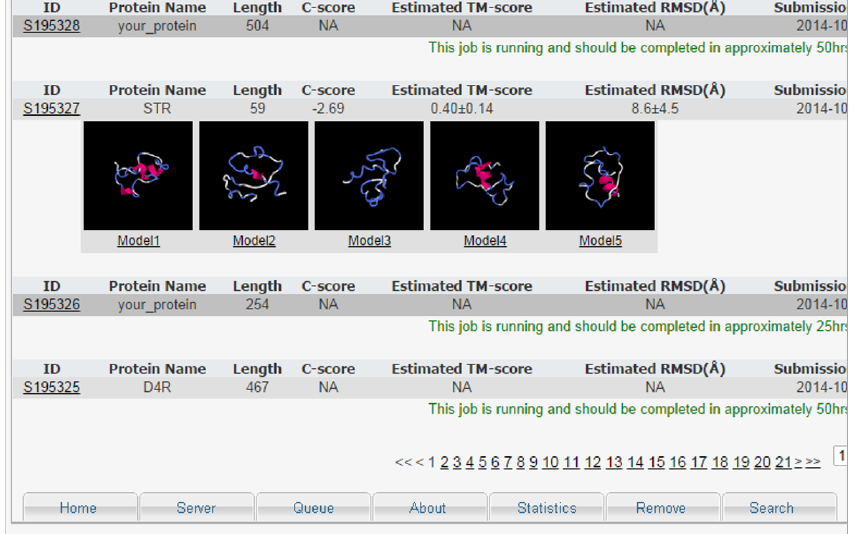
Figure 2. I-TASSER menu. The menu is displayed in various interface locations and in several different patterns. This window was presented at the bottom of the interface, which is not common. The ideal would be to present it always the same way in different parts of the interface.